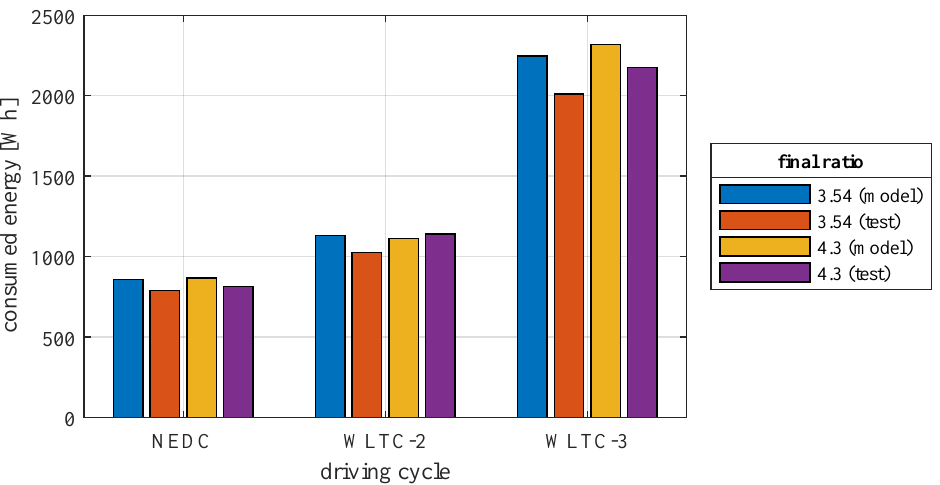
Figure 14. Energy consumed in driving cycles with final ratios 4.3 and 3.54. Model and test results are compared for both